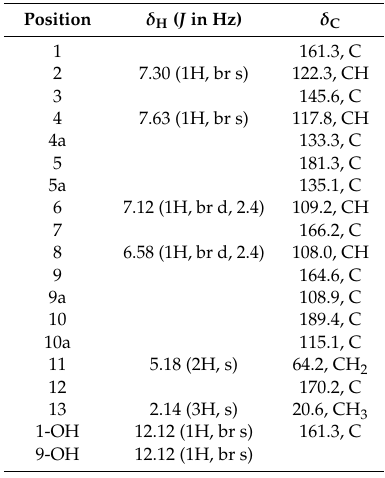
Table 3. 1 H-NMR (600 MHz) and 13 C-NMR (150 MHz) data for 3 in DMSO- d 6.